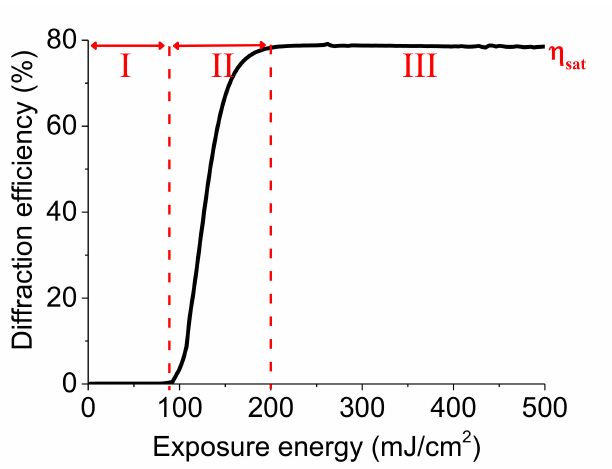
Figure 2. Typical di ff raction e ffi ciency behavior (sample P-2, with thickness 220 µ m).